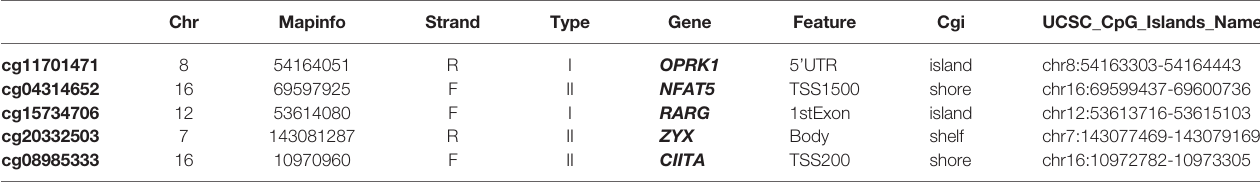
TABLE 2 | Five selected methylation